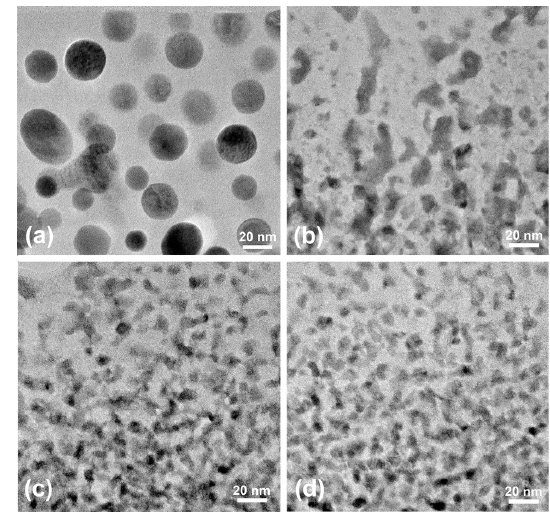
Figure 9. Zoom-in cross-section TEM of the annealed Hf 7 B 10 Si 32 C 2 N 44 film taken from ( a ) the top oxide layer, ( b ) transition layer and ( c ) top and ( d ) bottom section of the recrystallized layer.